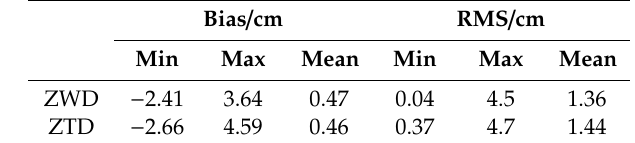
Table 3. Descriptive statistics of the bias and RMS of the zenith wet delay (ZWD) and ZTD values derived from the MERRA-2 data and compared to the radiosonde data from 2015.